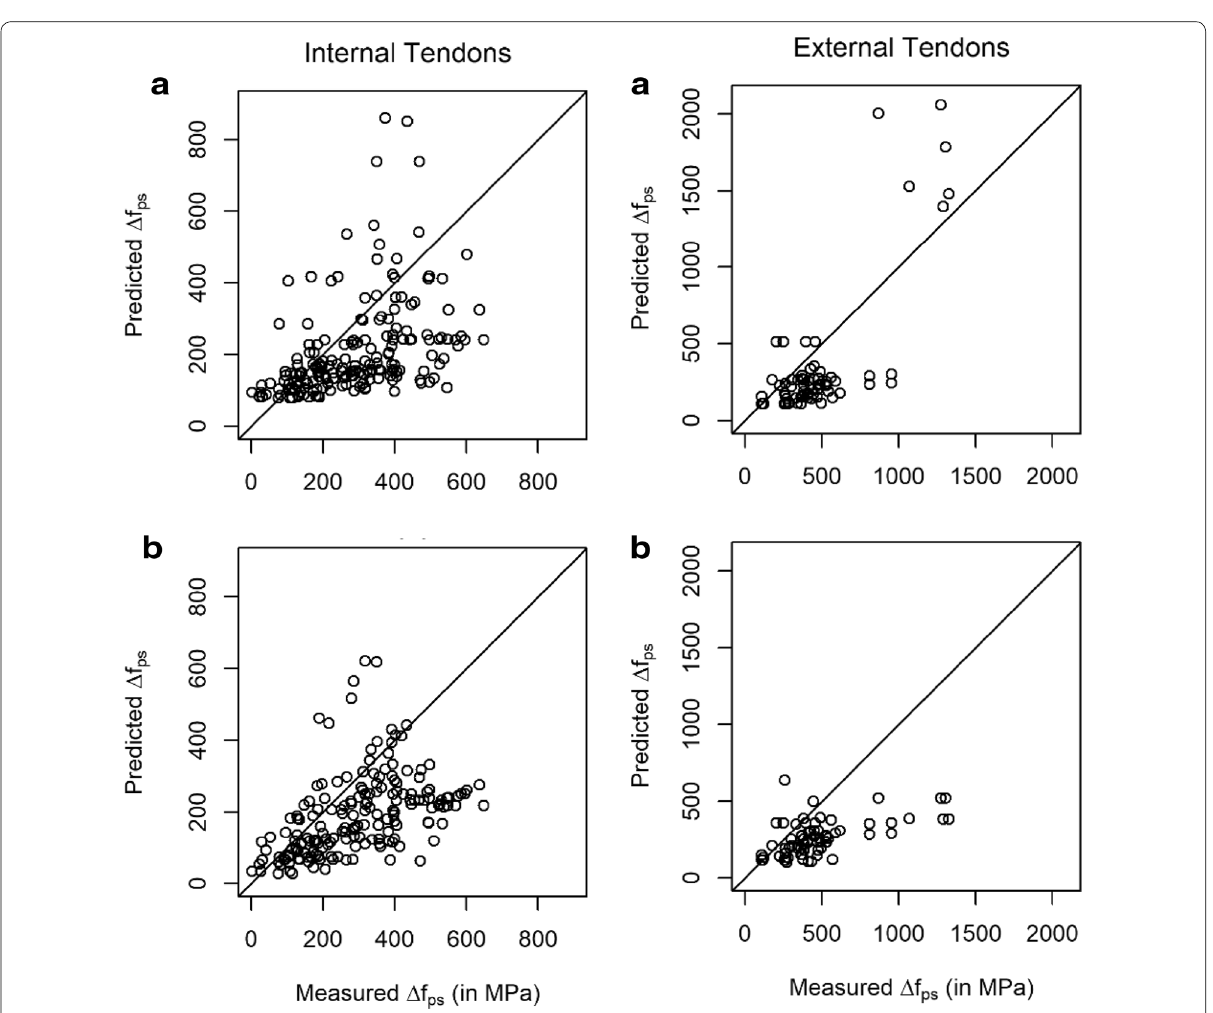
Fig. 6 Measured (cid:31) f ps vs. predicted (cid:31) f ps (in MPa) using the a ACI, and b AASHTO model equations (ACI 2008; AASHTO 2010)